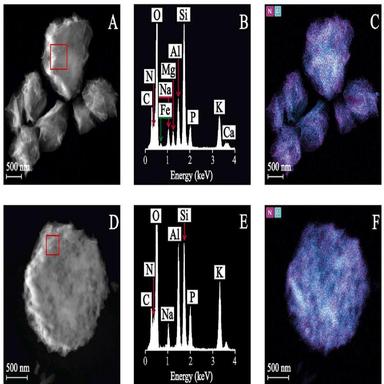
UHR-TEM microphotographs, EDX spectra and elemental maps of: hLF-Mt SD (a- c); hLF-Hal SD (d-f). EDX spectra were performed in red squares. (For interpretation of the references to colour in this figure legend, the reader is referred to the web version of this article.)